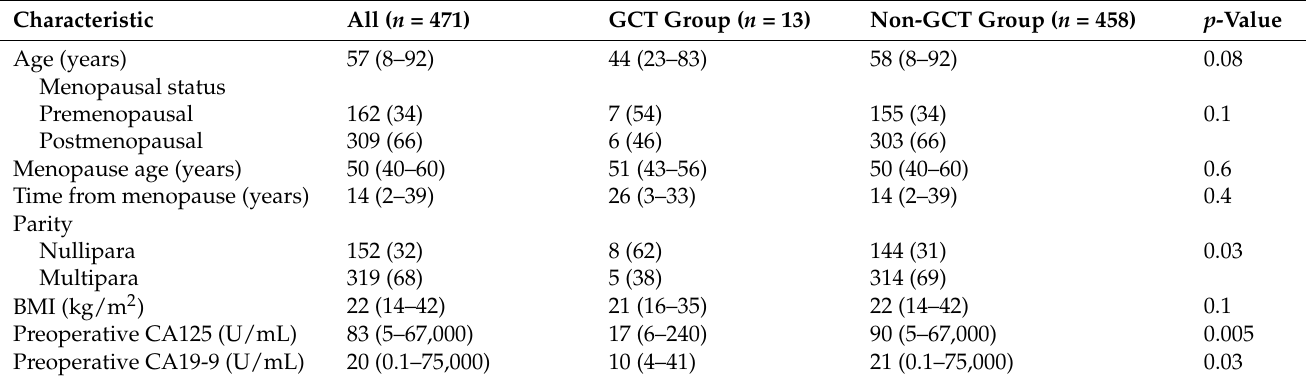
Table 1. Patient characteristics.